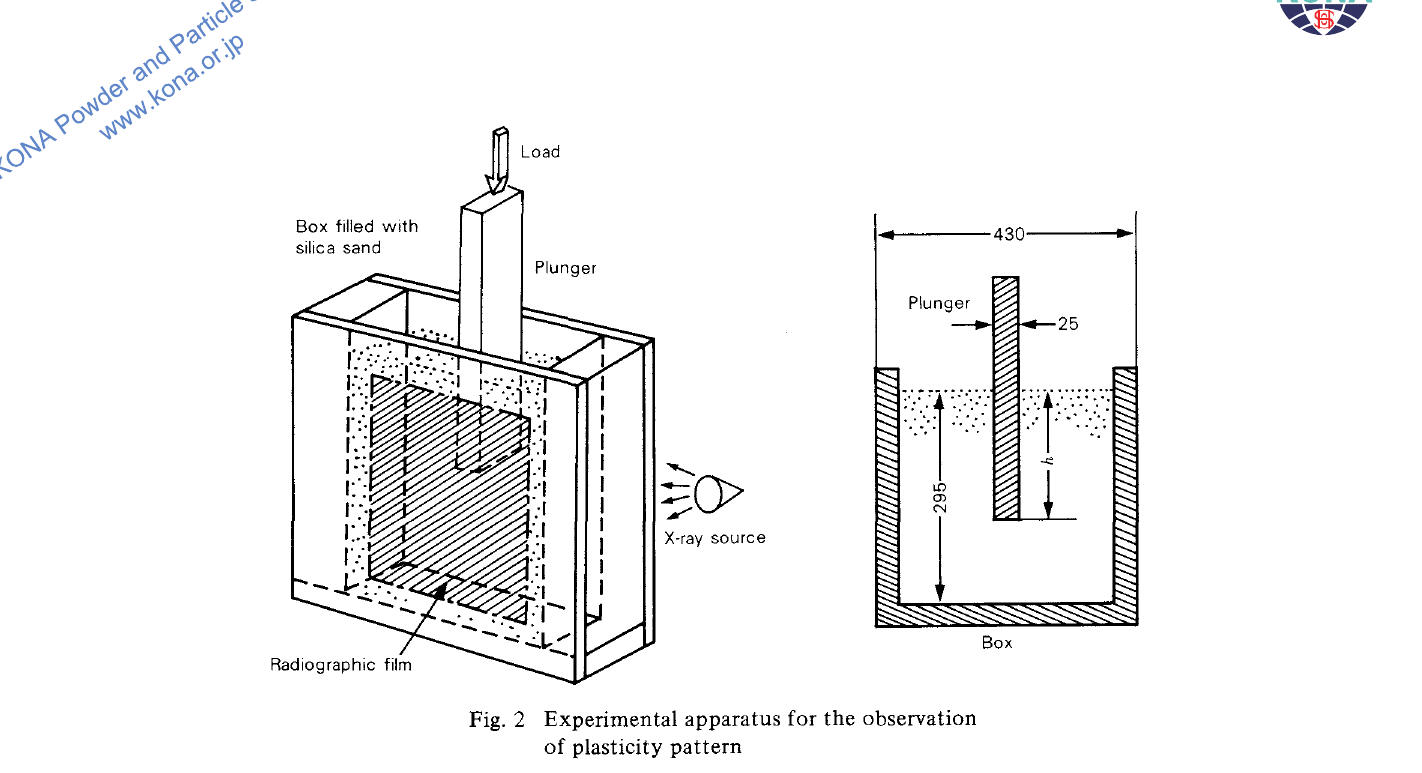
Fig. 2 Experimental apparatus for the observation of plasticity pattern